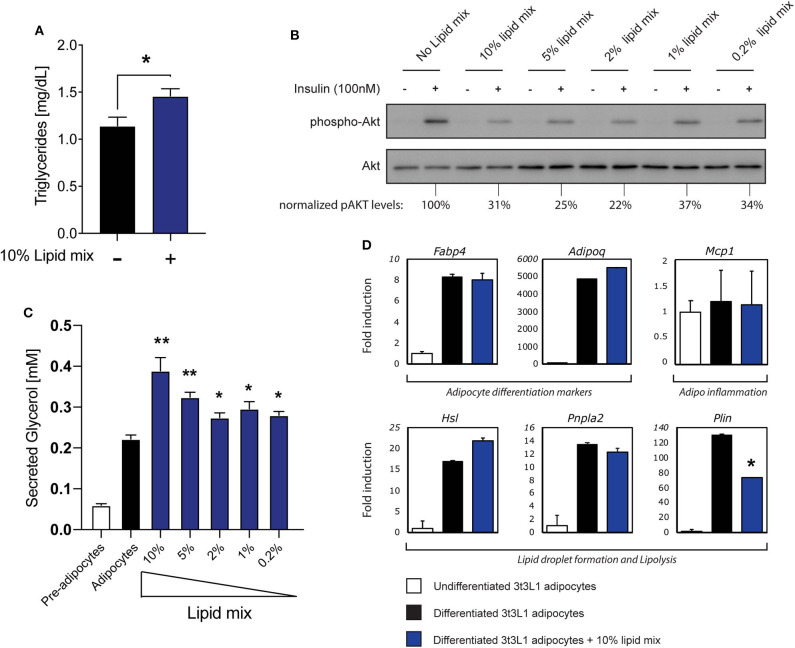
Stimulation with a lipid mixture causes an insulin resistance phenotype in 3T3-L1 adipocytes. (A) Mouse 3T3-L1 preadipocytes were differentiated into mature adipocytes and cultured with 10% lipid mixture for 4 days and intracellular triglyceride levels were determined. Statistical analysis via Students t-test against adipocytes glycerol secretion (NS P > 0.05, *P < 0.05, **P < 0.01, ***P < 0.001) (n = 3). (B) Mature 3T3-L1 adipocytes were treated with different concentrations (10–0.2%) Lipid Mixture for 4 days and deprived of insulin signaling before insulin stimulation (30 min). Lysates subjected to Western blot analysis. Western blot quantification of phospho-AKT (ser473) normalized to total AKT levels. (C) Quantification of glycerol secreted by 3T3-L1 adipocytes, and control pre-adipocytes, after 4 days in culture with titrated lipid mix dilutions. Statistical analysis via Students t-test against adipocyte glycerol secretion (NS P > 0.05, *P < 0.05, **P < 0.01) (n = 3). (D) Mouse 3T3-L1 preadipocytes were differentiated into mature adipocytes and treated with 10% lipid mix for 4 days before being subjected to RNA isolation and quantitative RT PCR. Transcriptional activity of genes involved in adipogenesis, inflammation and lipolysis are depicted as fold induction relative to undifferentiated 3T3-L1 adipocytes. Data are normalized to housekeeping gene 36B4 and presented as mean +/– SD (n = 6).